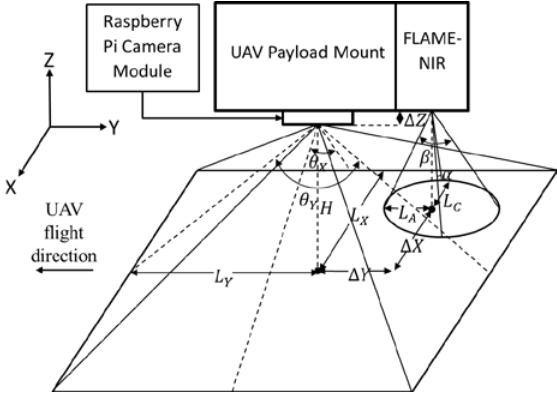
Figure 5. Side view of FLAME-NIR spectrometer and Raspberry Pi camera payload geometry.